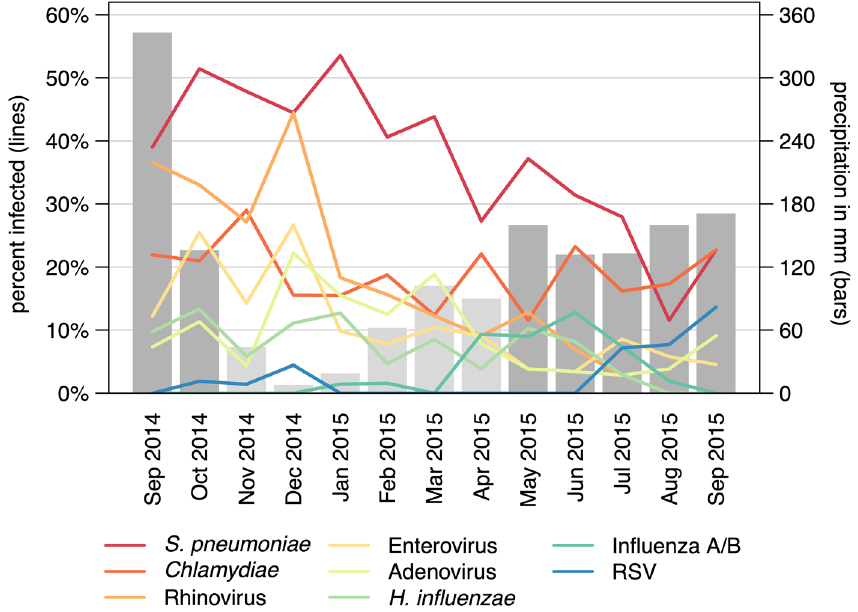
Figure 3. Proportion of infections in study participants over the study months. Monthly rainfall is shown in the bars, where a monthly precipitation > 125 mm is considered rainy season (dark grey bars).